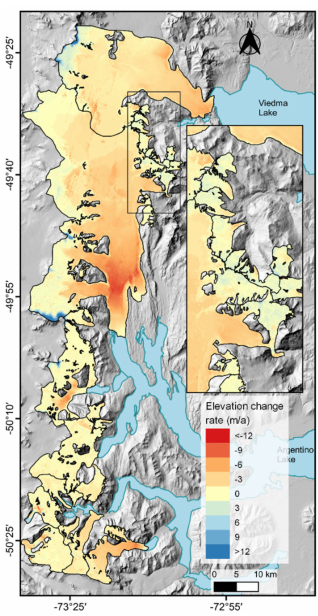
Figure 7. Elevation changes rate map